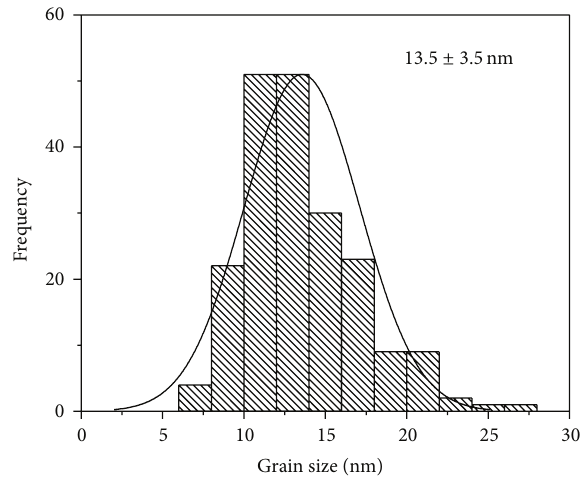
Figure 2: Histogram distribution of grain size of CuS thin